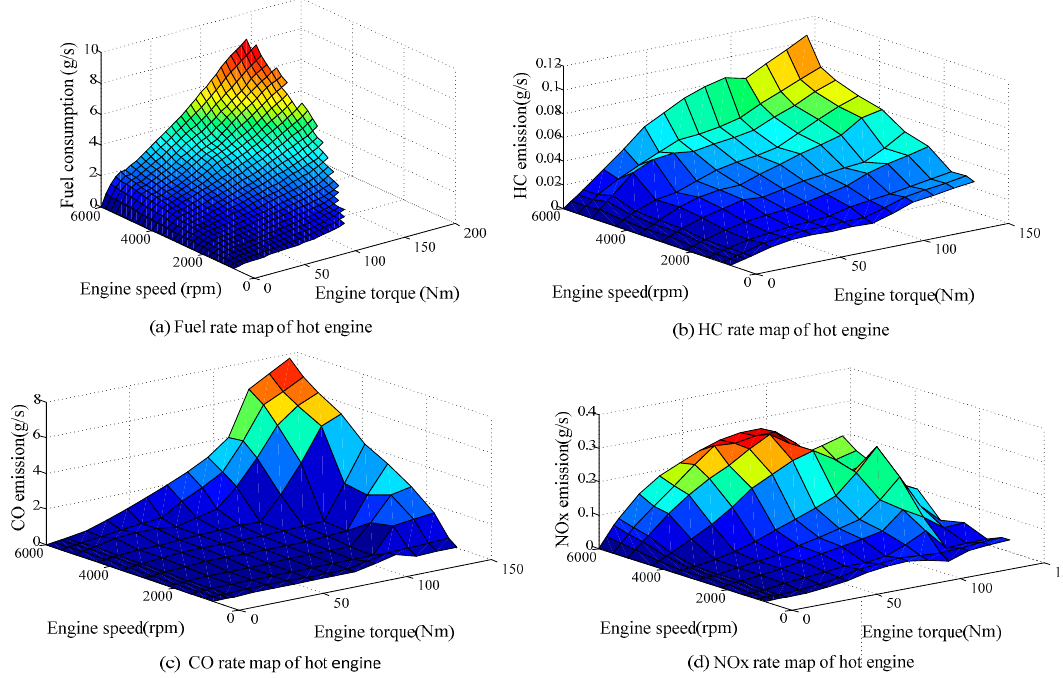
Figure 3. The fuel consumption rate and emissions rate maps of the hot engine.